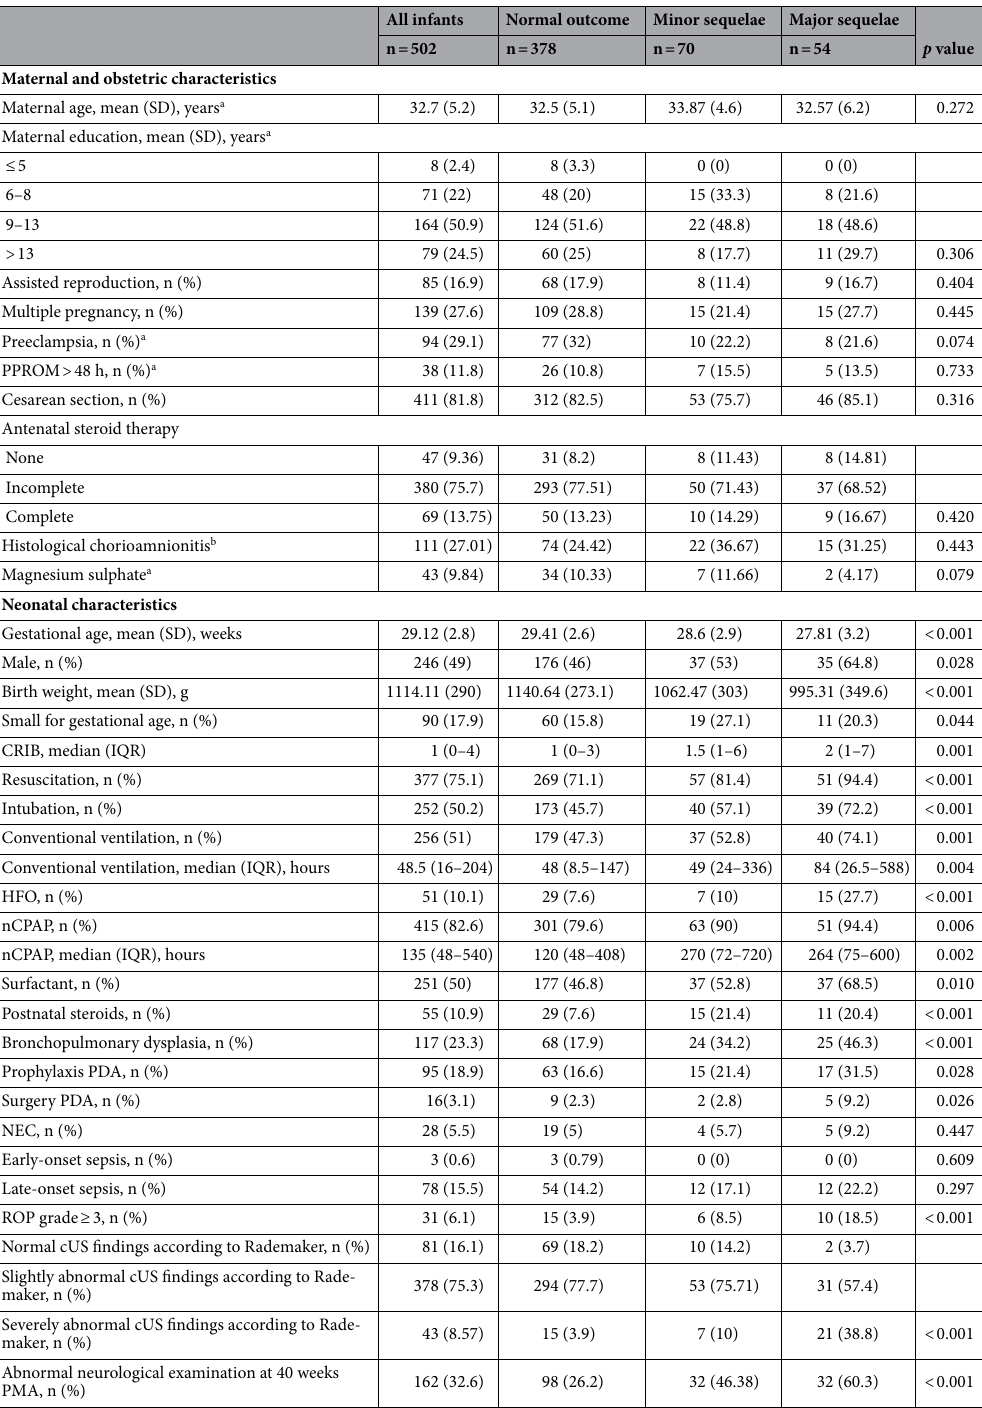
Table 1. Clinical characteristics of the entire study sample and according to neurodevelopmental outcome. p values for the comparison between the three groups are reported. PPROM preterm prelabor rupture